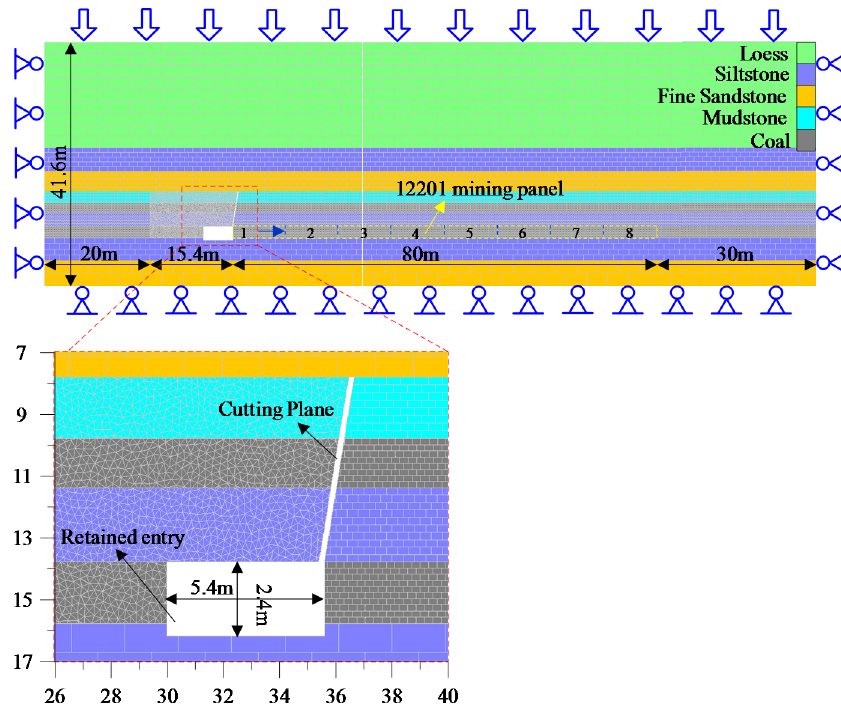
Figure 4. Numerical model of non-pillar longwall mining.4.2. Calibrated Rock Mass Parameters.